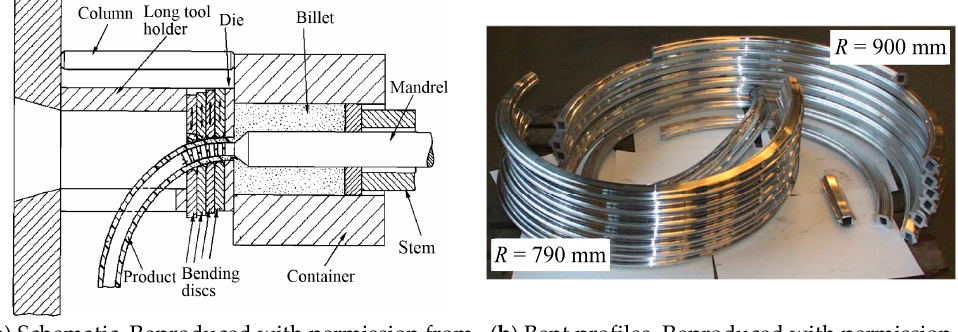
Figure 20. Curved profile extrusion (CPE) using a segmented guiding device [79,80].